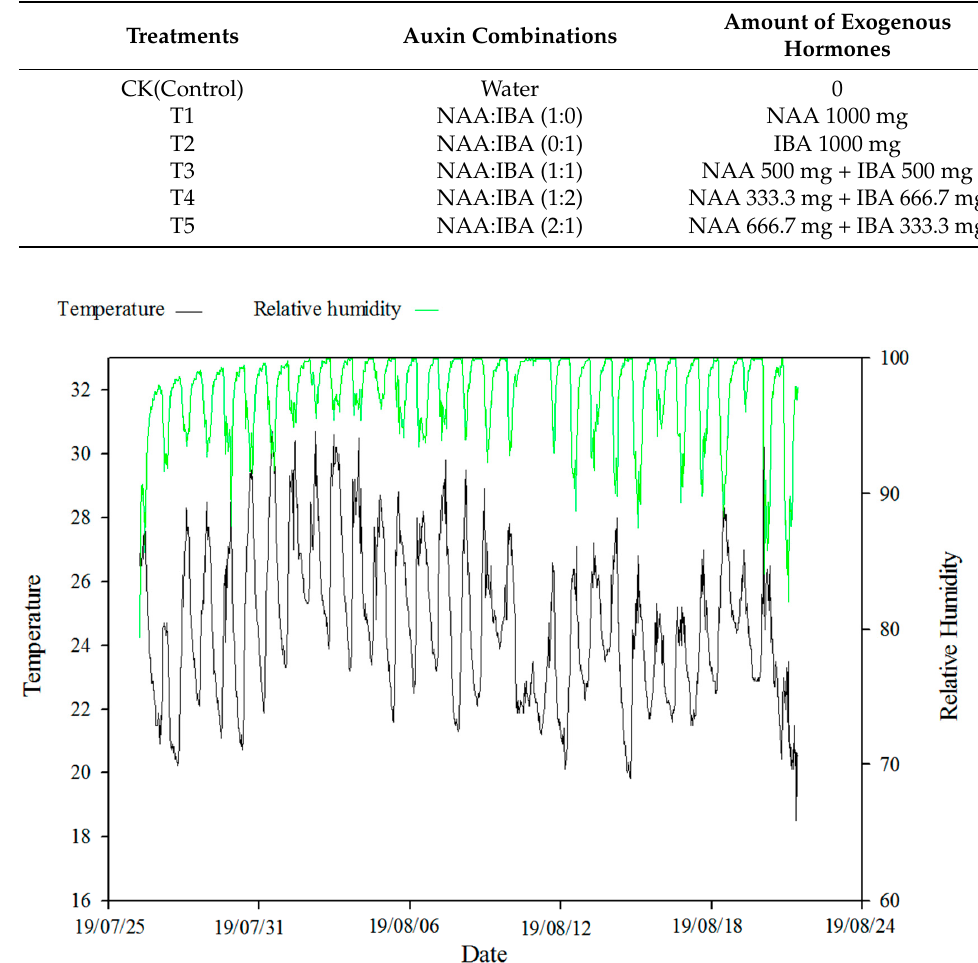
Figure 3. Dynamic changes of ambient air temperature and relative humidity of the cutting seedbeds. Temperature and humidity data were recorded each half hour.